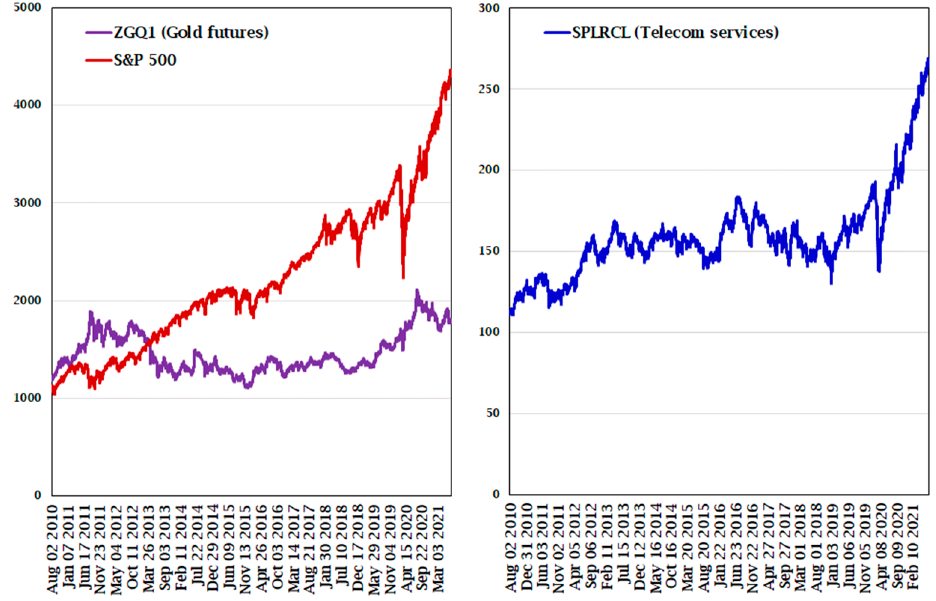
Figure 7. S&P 500, gold futures and telecom services indices (daily obs.).